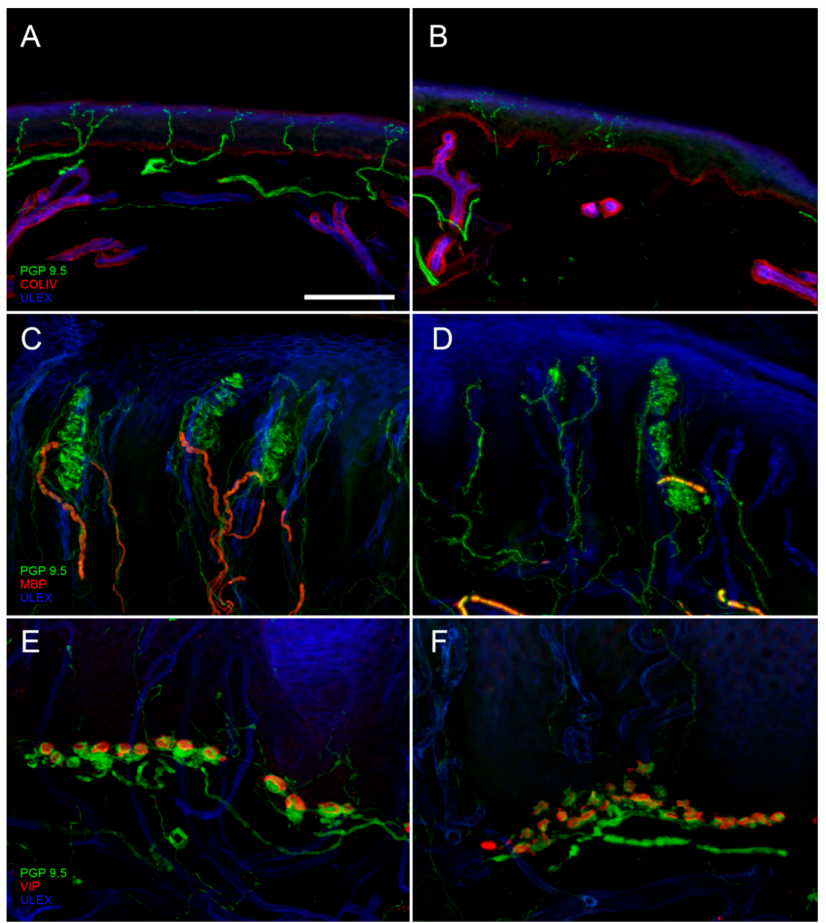
Figure 1. Digital confocal images from hairy ( A , B ) and glabrous skin ( C – F ) showing epidermal and dermal innervation in a healthy control ( A , C , E ) and in a patient with diabetic neuropathy ( B , D , F ). In the patient skin, a loss of Intraepidermal Nerve Fibers (IENF) is evident (( B ) compared to ( A )) as well as a loss of Meissner corpuscles and their myelinated a ff erences associated to morphological abnormalities of the surviving structures (( D ) compared to ( C )). Moreover, morphological abnormalities of a Merkel complex (axonal swelling and fragmentation) are present (( F ) compared to ( E )). In green: nerves marked with the pan-neuronal protein gene product 9.5 (PGP9.5) antibody. In blue: endothelia and epidermis marked with ULEX europaeus. In red: basement membrane and blood vessels marked with Collagen IV (Col IV) antibody in ( A ) and ( B ); myelined fibers marked with myelin basic protein (MBP) antibody in ( C ) and ( D ); Merkel cells marked with vasoactive intestinal peptide (VIP) antibody in ( E ) and ( F ). Scale bar: 100 µ m in ( A – D ); 50 µ m in ( E , F